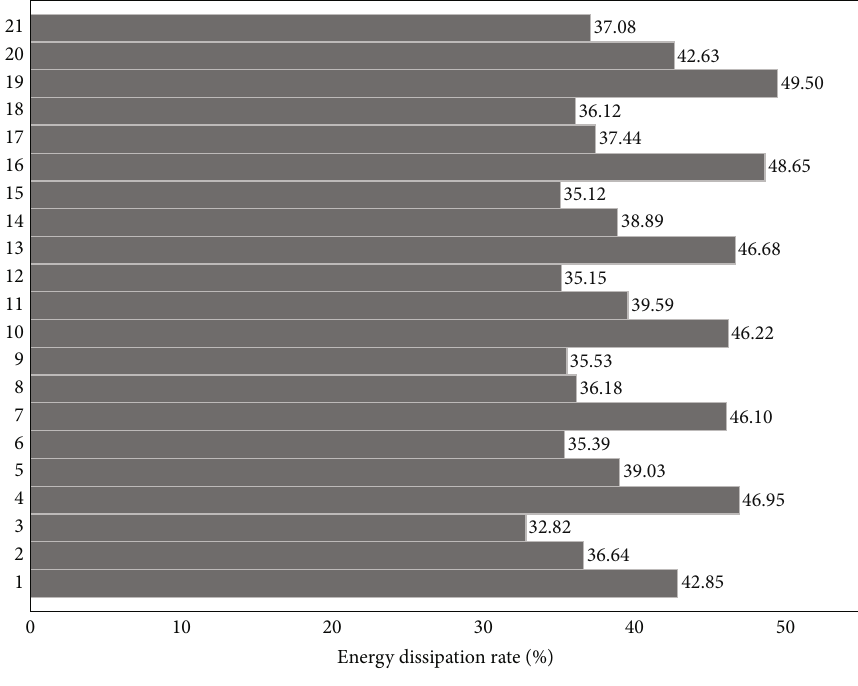
Figure 10: Calculated energy dissipation rates of the R-SEDs in the 21